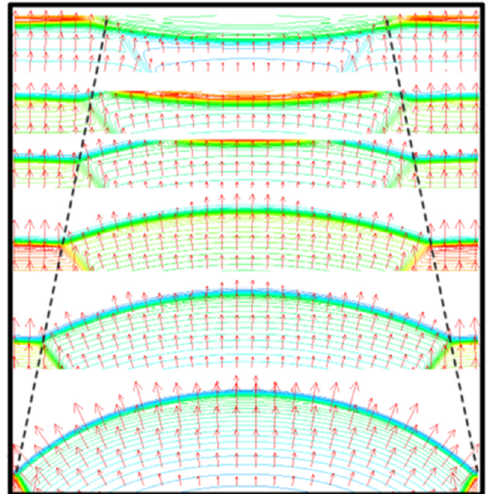
Figure 9. The cloud diagram of the convergence effect of shock waves at the corner at different K values when b = 500 mm and W = 100 g.